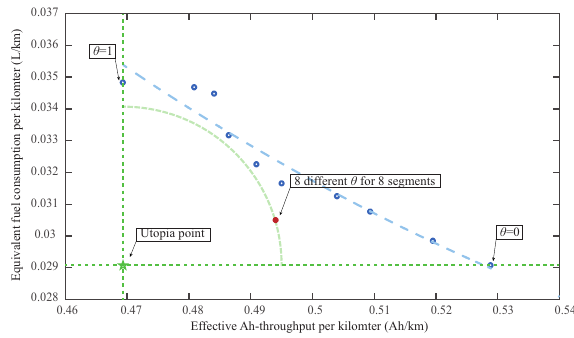
Figure 10. The Pareto set obtained by only the SDP algorithm with sweeping different weights θ between energy consumption and battery health and the solution obtained by SDP-PSO with the eight different weights θ for the second week Thursday speed